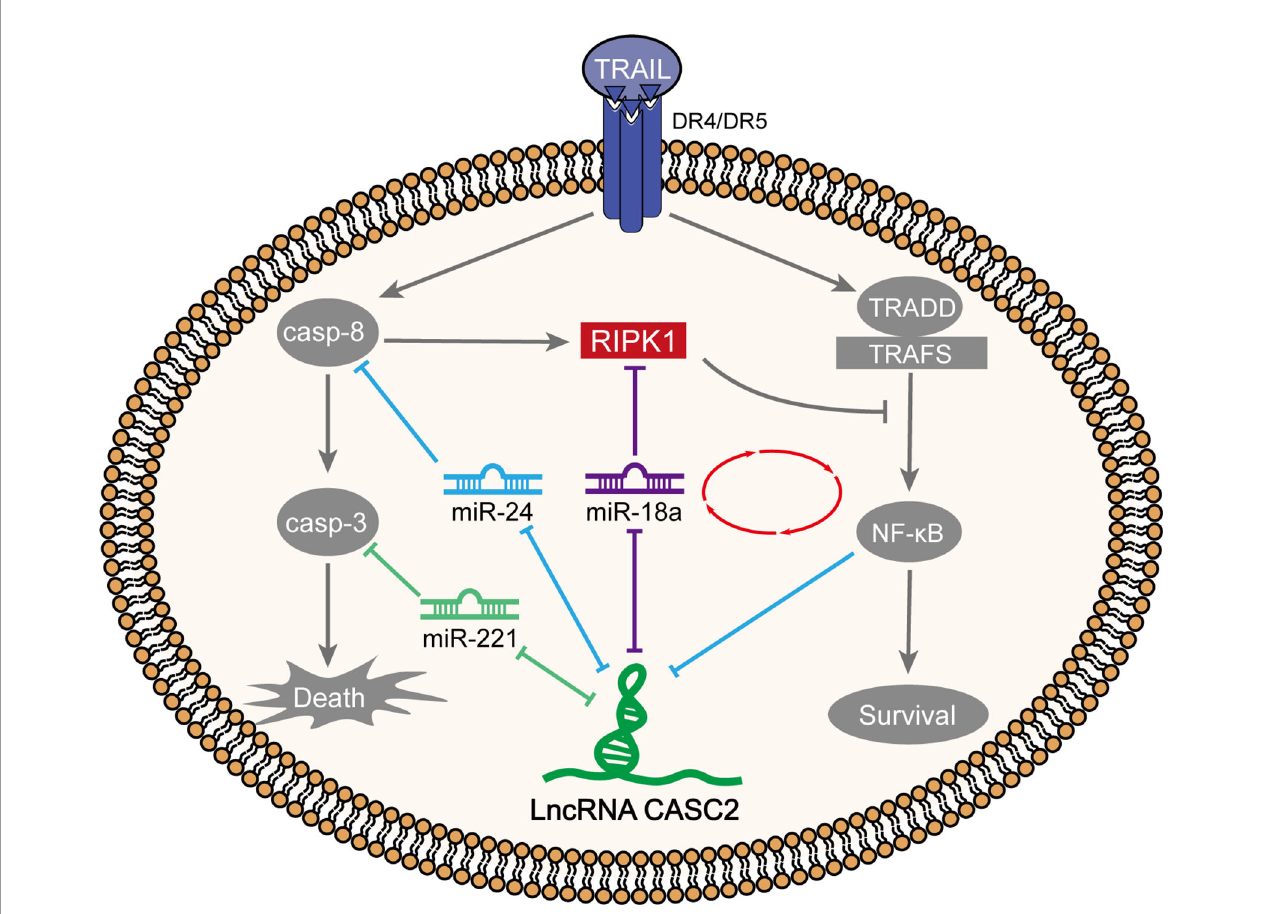
FIGURE 10 | A schematic diagram showing two different modes of TRAIL acting on TRAIL-sensitive and TRAIL-resistant cell lines through the caspase cascades and NF- k B signaling,